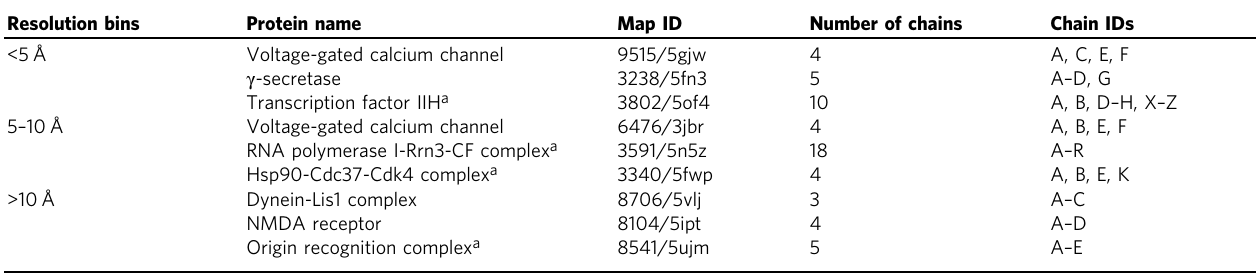
Table 3 EM maps used in partial map alignment